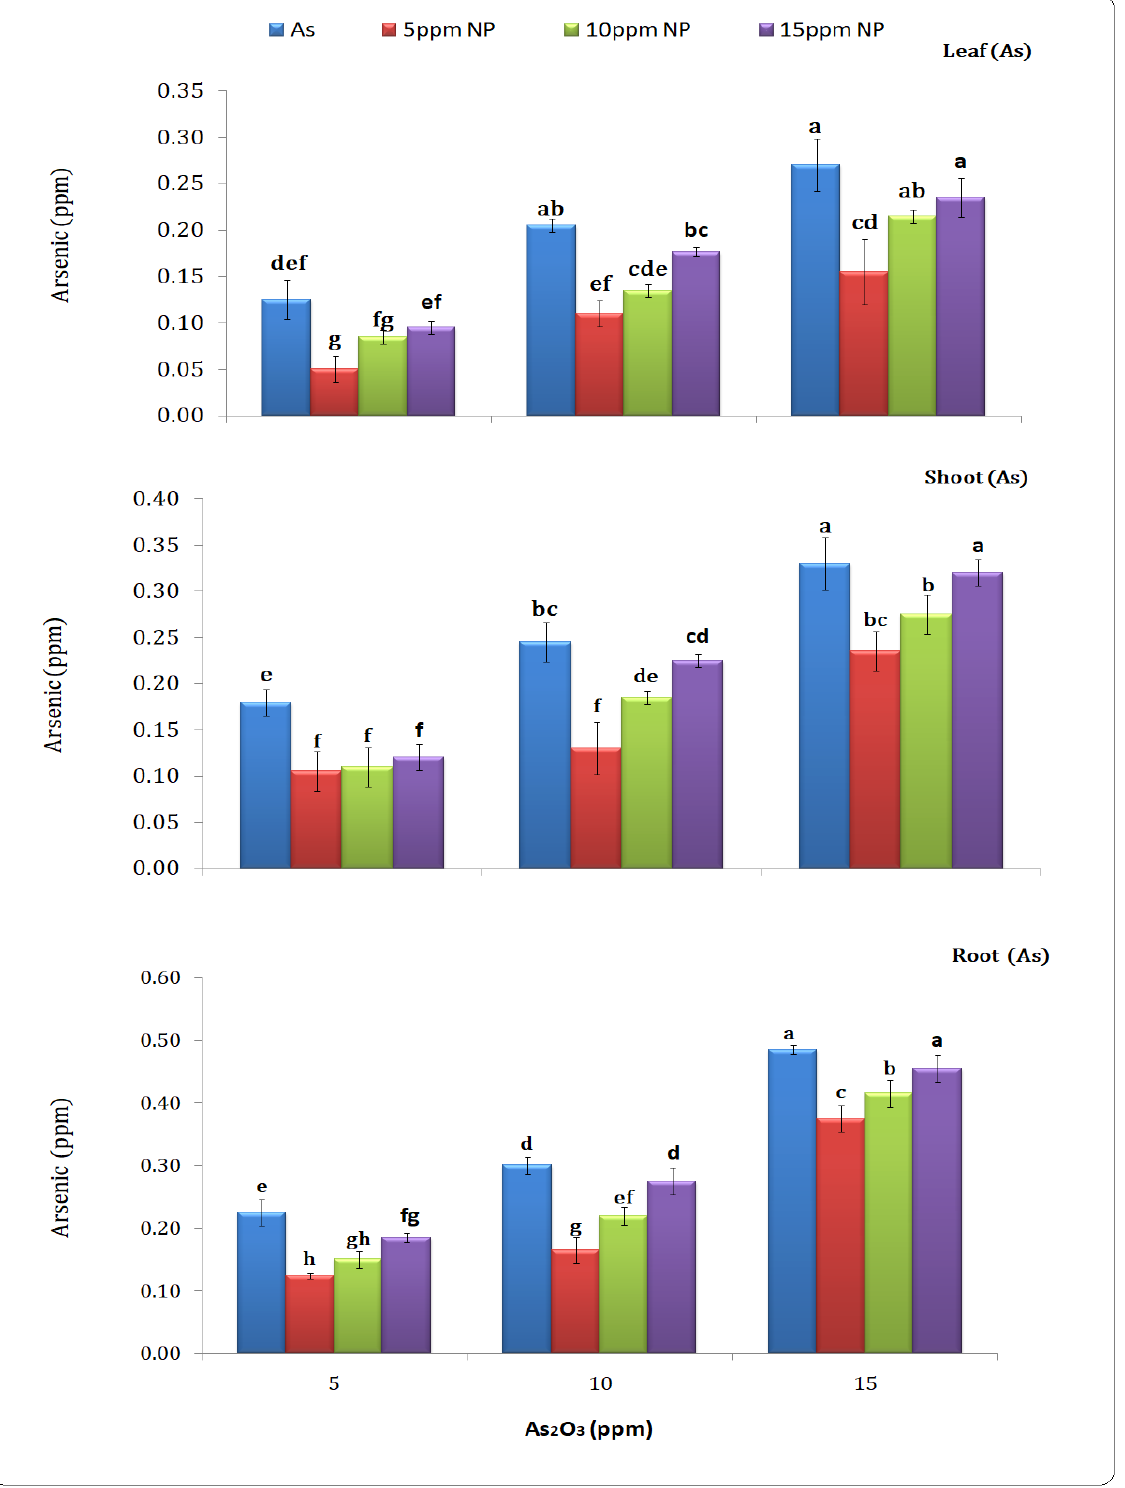
Figure 7. Effect of Bacillus subtilis- synthesized iron oxide nanoparticles on the arsenic content of rice ( Oryza sativa L.) in arsenic contaminated water. Different letters indicate significant differences ( p < 0.05) between treatments.